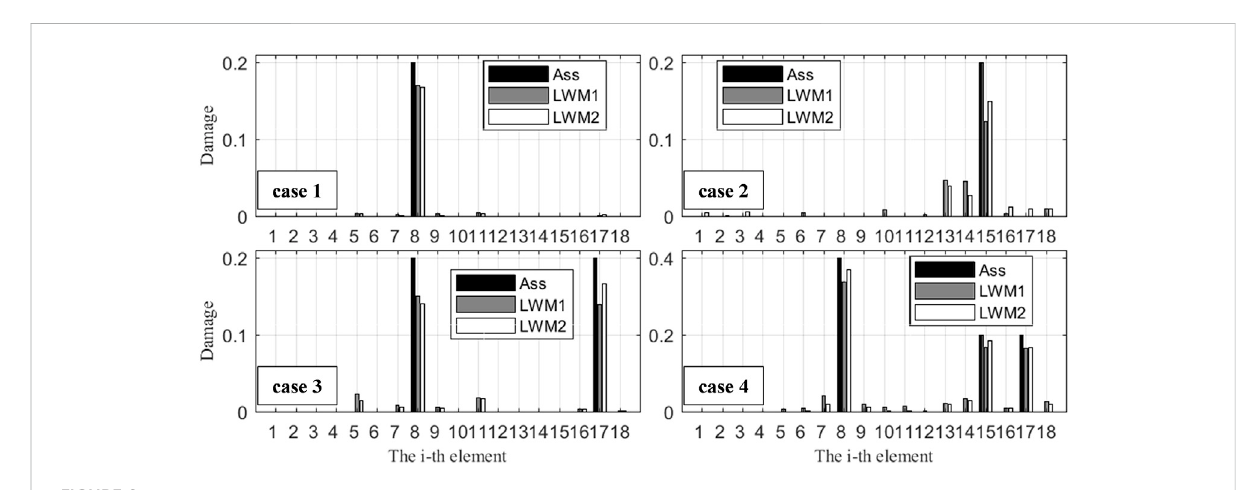
FIGURE 9 SDD results of the two-storey plane steel frame.